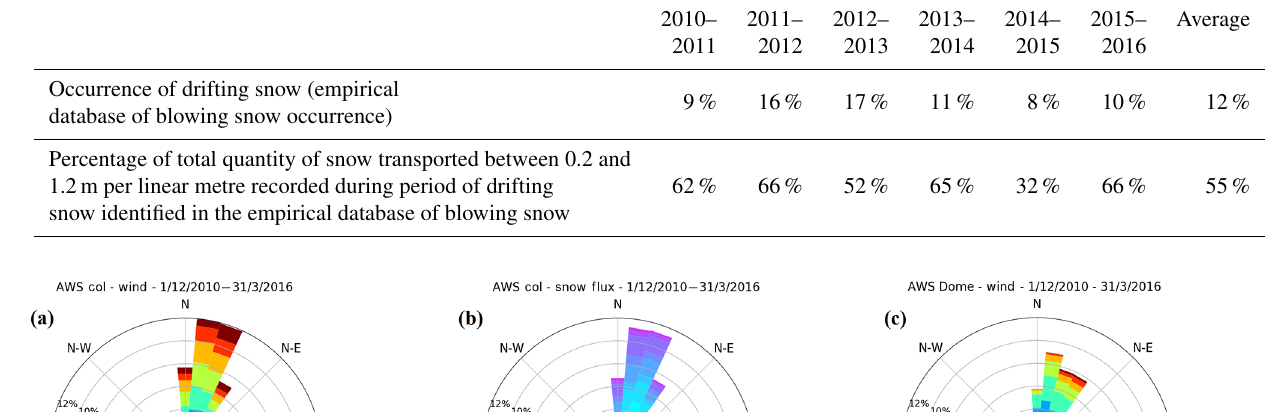
Table 3. Ratio between the quantity of snow transported between 0.2 and 1.2m per linear metre during the periods identified as blowing snow periods in the empirical database and the total quantity of snow observed during the same winter season.